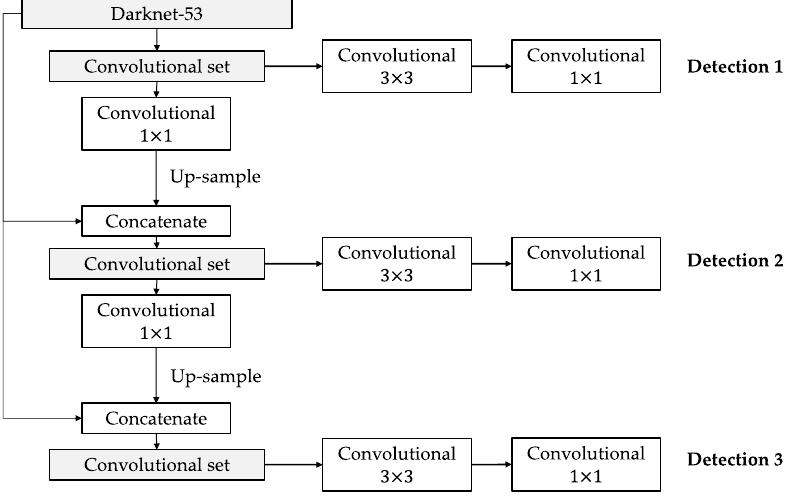
Figure 4. Architecture YOLOv3.